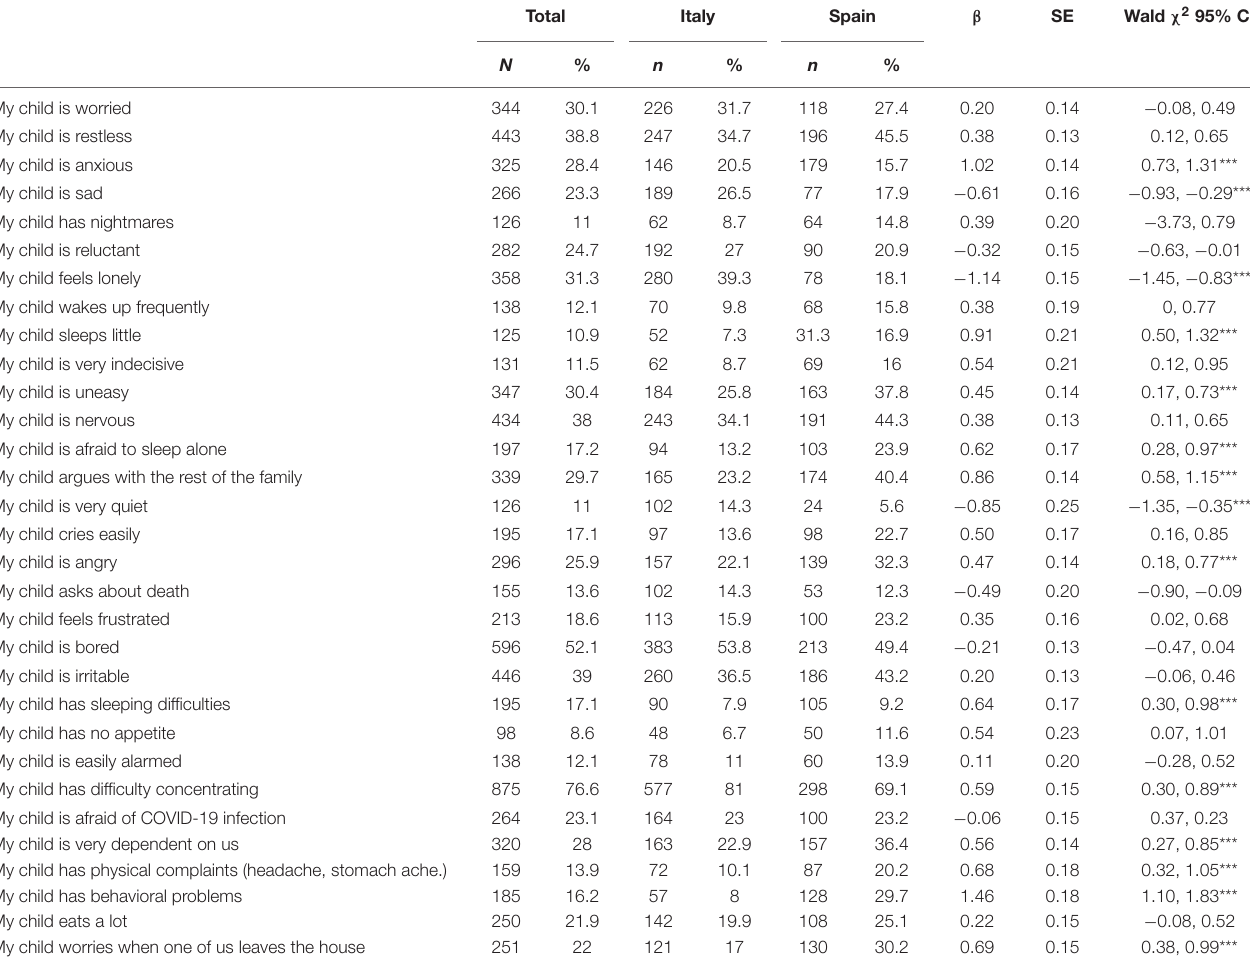
TABLE 2 | Primary caregivers’ perception of the emotional and behavioral effects of the quarantine in their